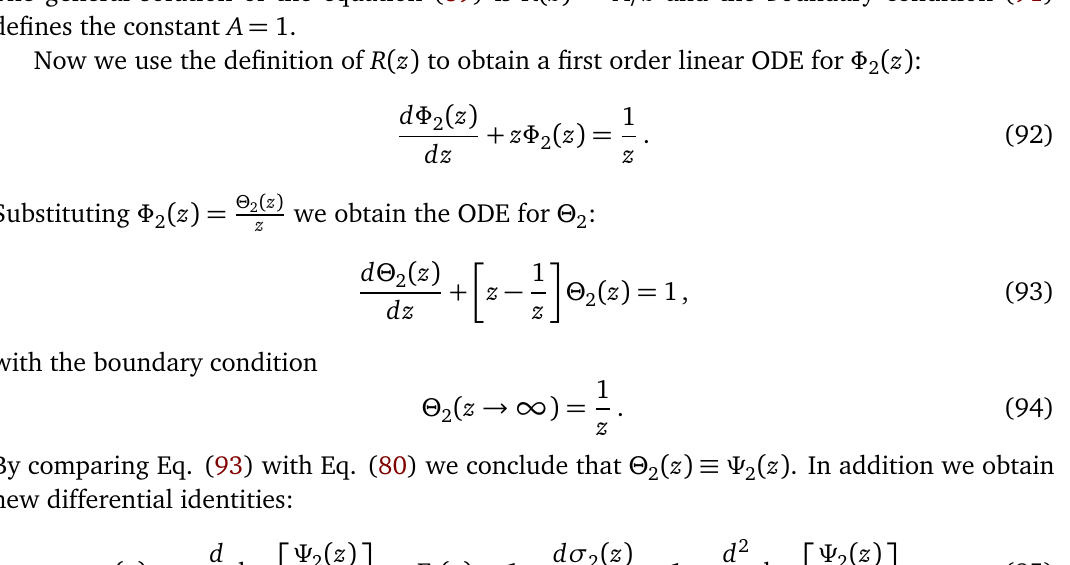
Figure 10: Left: Re [ Ψ R (red curve), Im [ σ R